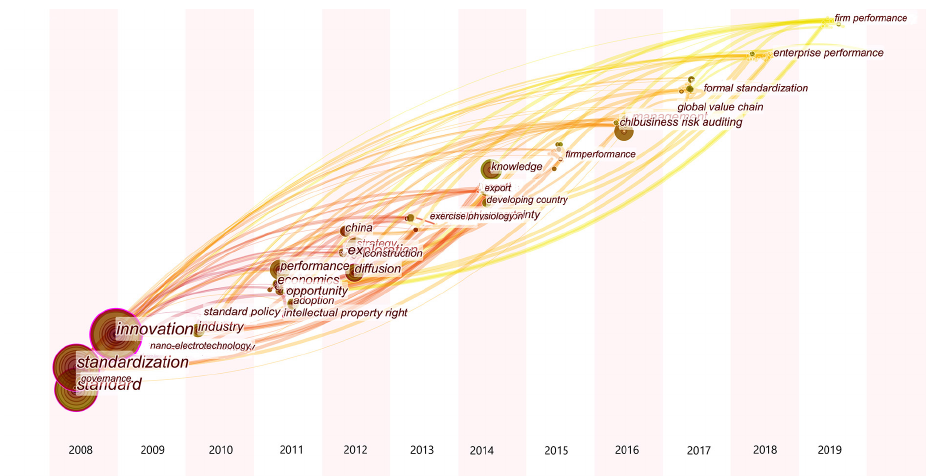
Figure 1. Keywords summary by the timeline